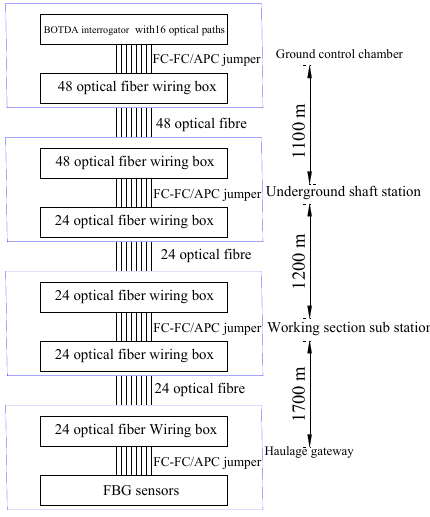
Figure 16. Schematic of the optical path for data transmission at Zhuji coal mine.